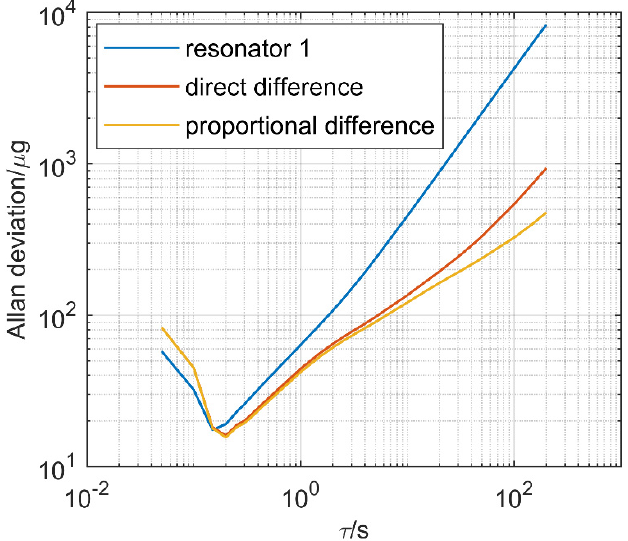
Figure 8. Measured Allan deviation during the temperature ramp